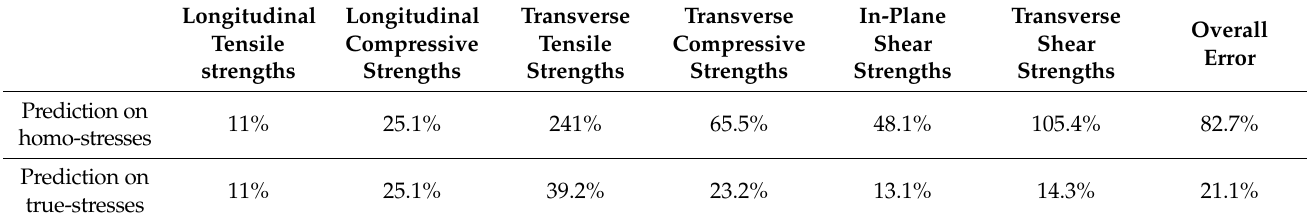
Table 3. Averaged errors between predictions and measurements for uniaxial strengths of the nine UD composites used in